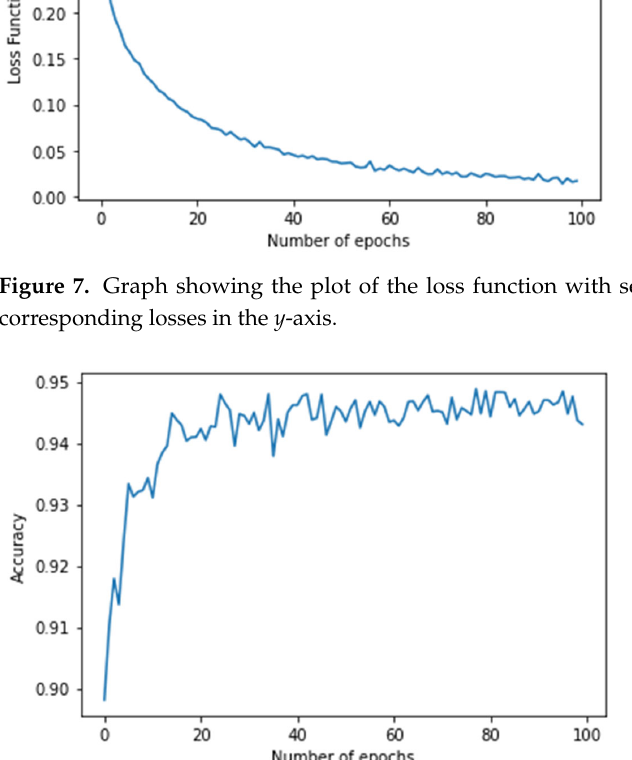
Figure 8. Graph showing the accuracy vs. the number of epochs with the X ‐ axis as epochs and the Y ‐ axis as its corresponding accuracies.